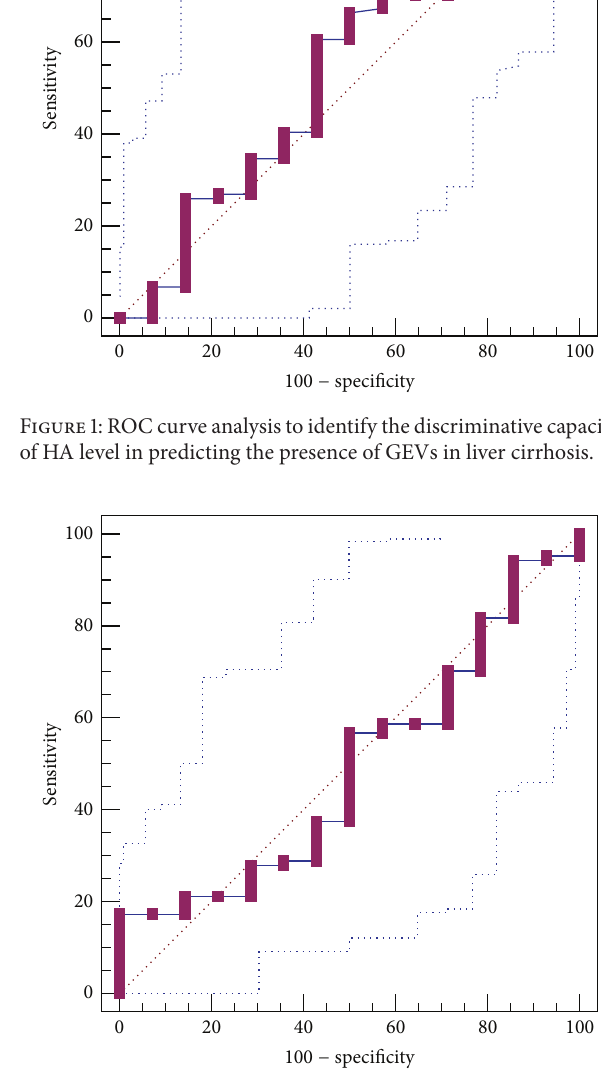
Figure 2: ROC curve analysis to identify the discriminative capacity of LN level in predicting the presence of GEVs in liver